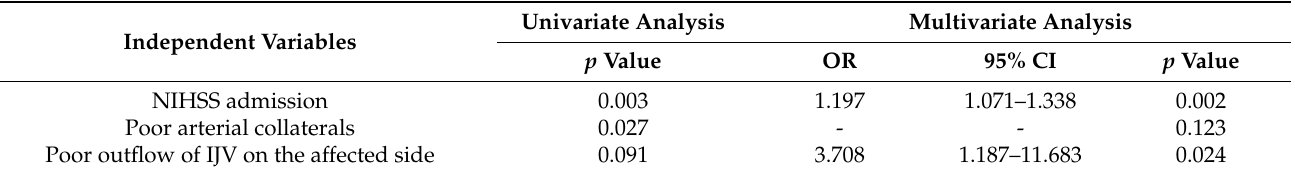
Table 3. Multivariable logistic regression to predict hemorrhagic transformation on follow-up imaging in the study